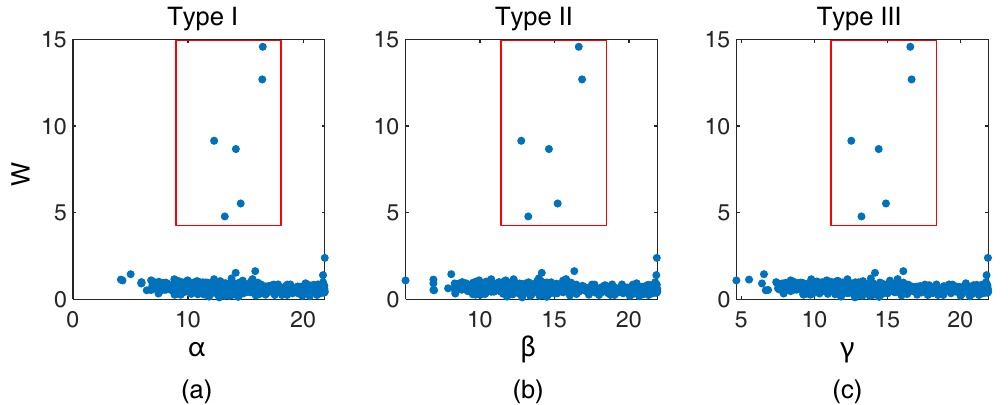
Figure 2. Illustration of different Decision-graph-based methods for determining the inter-cluster edges. ( a – c ) Different types of scatter-plot-based cutting (Type I: a; Type II: b; Type III: c). The pop-out points within the red rectangles correspond to the inter-cluster